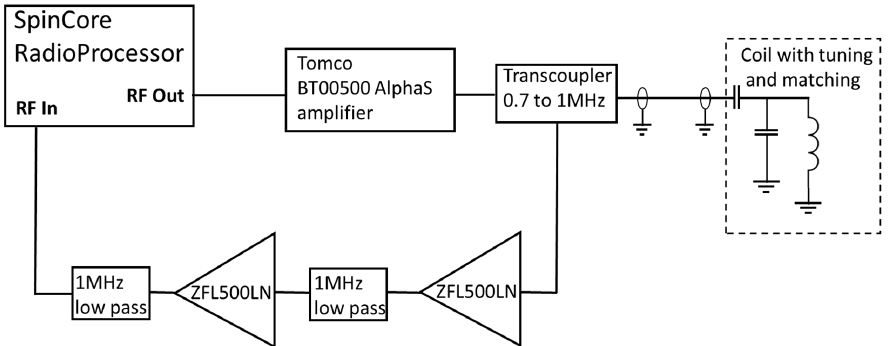
Figure 3. Schematic diagram of the NMR electronics.